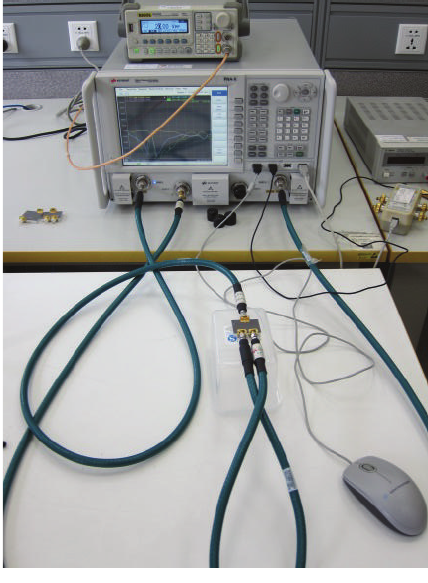
Figure 7: The testing